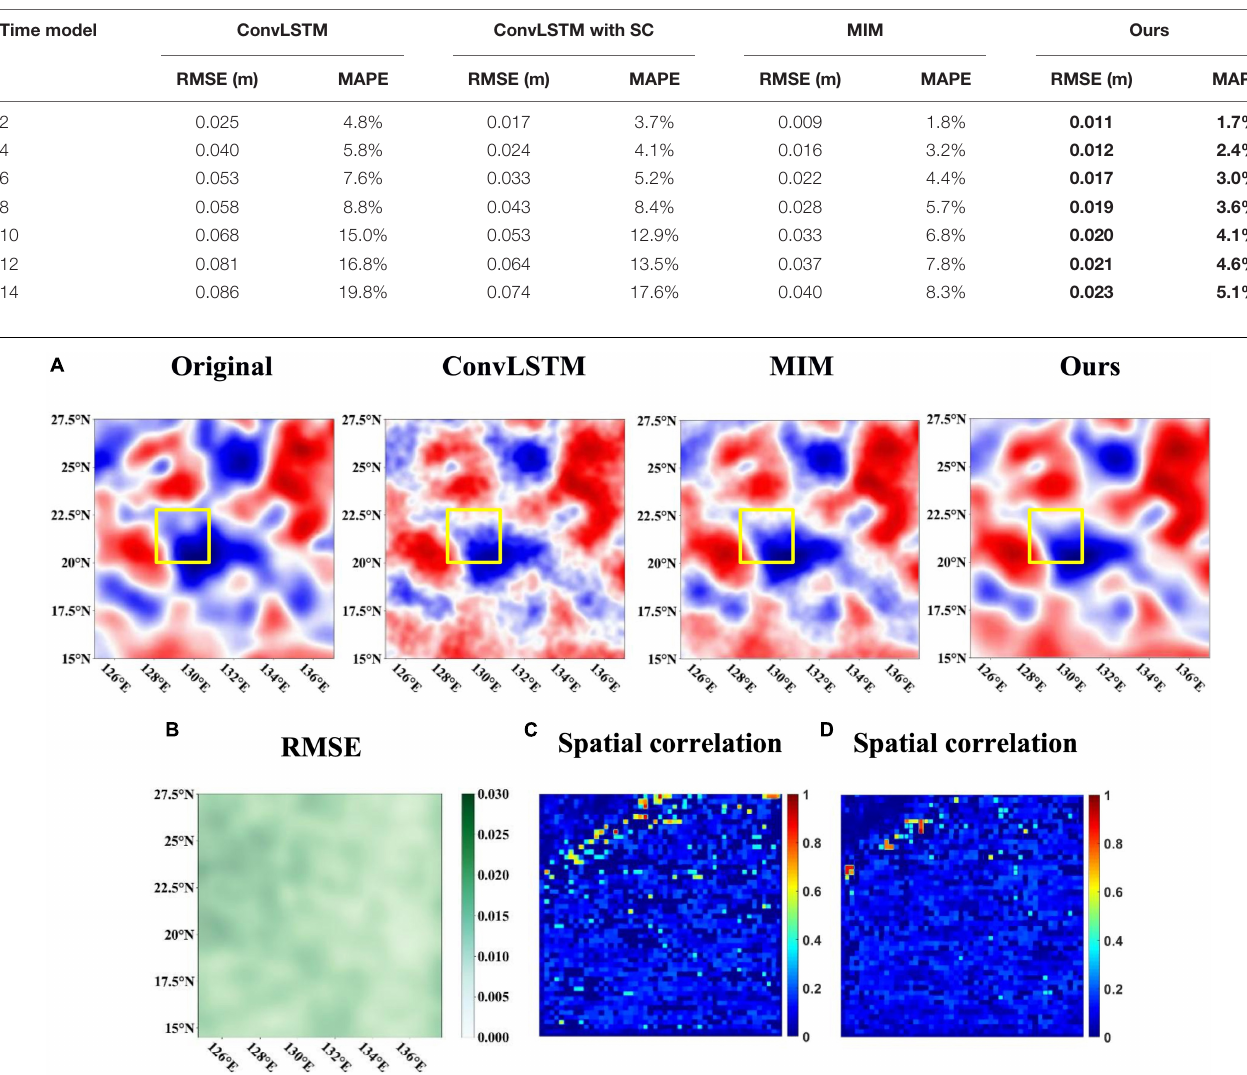
TABLE 5 | Performance comparison among classical ConvLSTM, original MIM, ConvLSTM with scheduled sampling (SC), and the proposed scheme. Time model